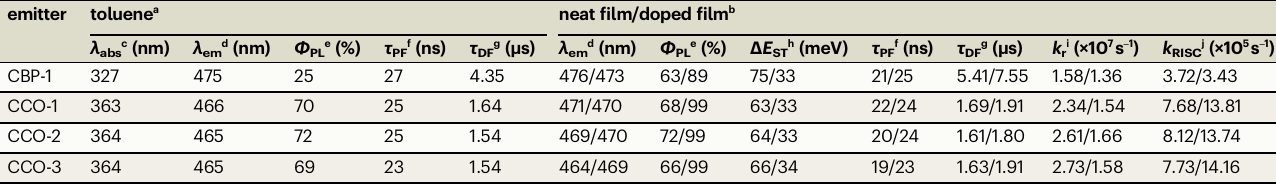
Table 1 | Photophysical properties of CBP-1, CCO-1, CCO-2 and CCO-3 emitter toluene a neat fi lm/doped fi lm